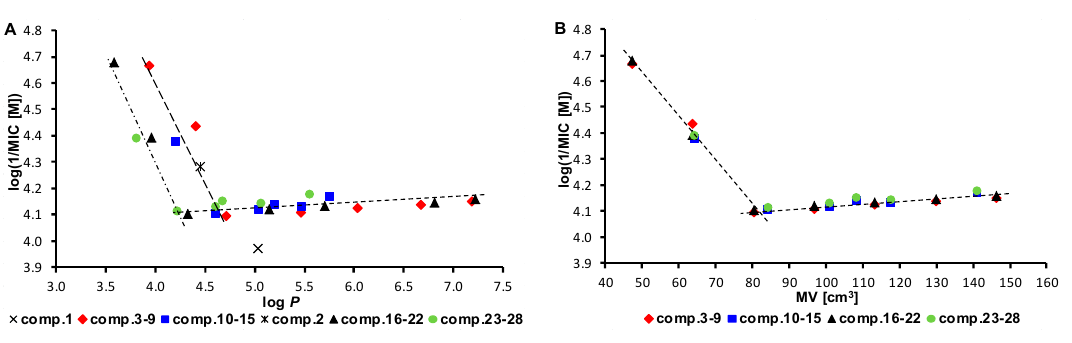
Figure 1. Dependence of the in vitro antimycobacterial activity against M. kansasii DSM 44162 log (1/MIC [M]) of the tested compounds on lipophilicity, expressed as log P ( A ) and bulkiness/molar volume (MV [cm 3 ]) of individual R 2 substituents ( B ).